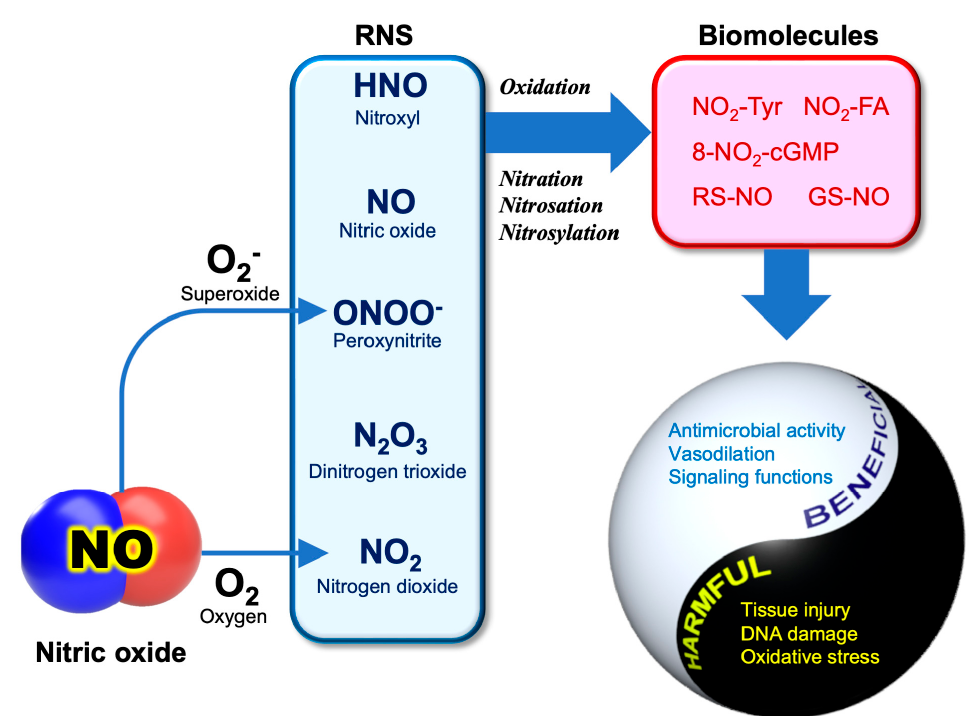
Figure 1. NO and RNS in COVID-19. NO and its derived reactive molecules are frequently referred to as “reactive nitrogen species” (RNS). Peroxynitrite (ONOO − ) is a reaction product between NO and superoxide (O 2 − ). RNS potentially mediate the oxidation, nitration, nitrosation and nitrosylation of biomolecules. Those reactions exhibit both beneficial and harmful effects. NO 2 -Tyr, nitro-tyrosine; 8-NO 2 -cGMP, 8-nitroguanosine 3 ′ ,5 ′ -cyclic monophosphate; NO 2 -FA, nitro-fatty acids; RS-NO, S -nitrosothiol; GS-NO, S -nitrosoglutathine.